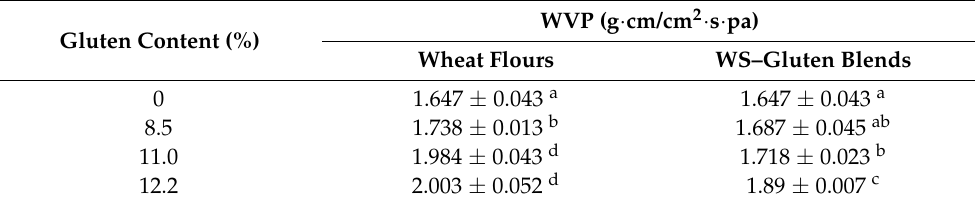
Table 4. Water vapor permeability for the films of pure WS, wheat flours, and WS – gluten blends with different protein contents (8.5%, 11.0%, and 12.2%).